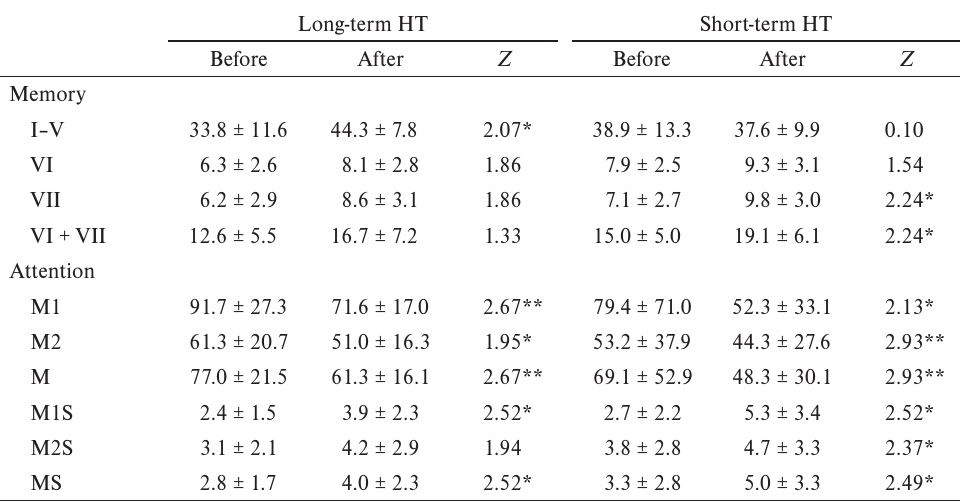
Measured parameters (Mean ± SD) and a significance of the differences in memory and attention evaluation Long-term HT